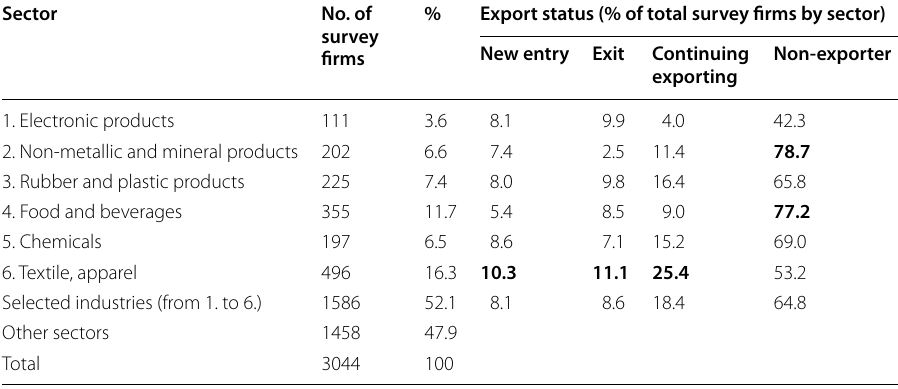
Dominant sector of each export status type has shown in bold number Source: author’s calculations using the World Bank Enterprise Survey and ASEAN